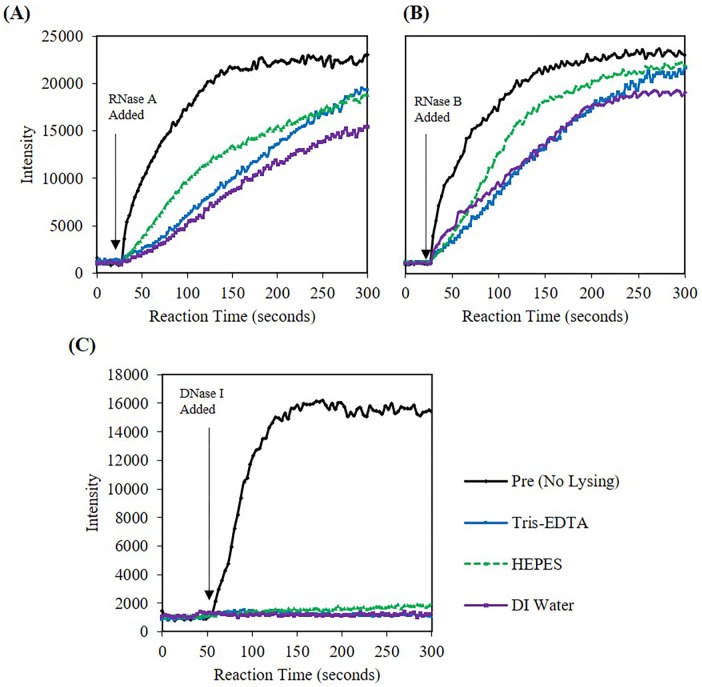
Fluorescent intensity at 520 nm (RNase A/B) and 556 nm (DNase I) versus time for nucleases in 1 mM buffers lysed with Lyse-It at 50% power for 60 seconds (A) 20 pM RNase A (B) 46 pM RNase B, (C) 10.5 nM DNase I.In general, HEPES buffer was seen to protect the nuclease from becoming more inactive as compared to Tris-EDTA or DI water.